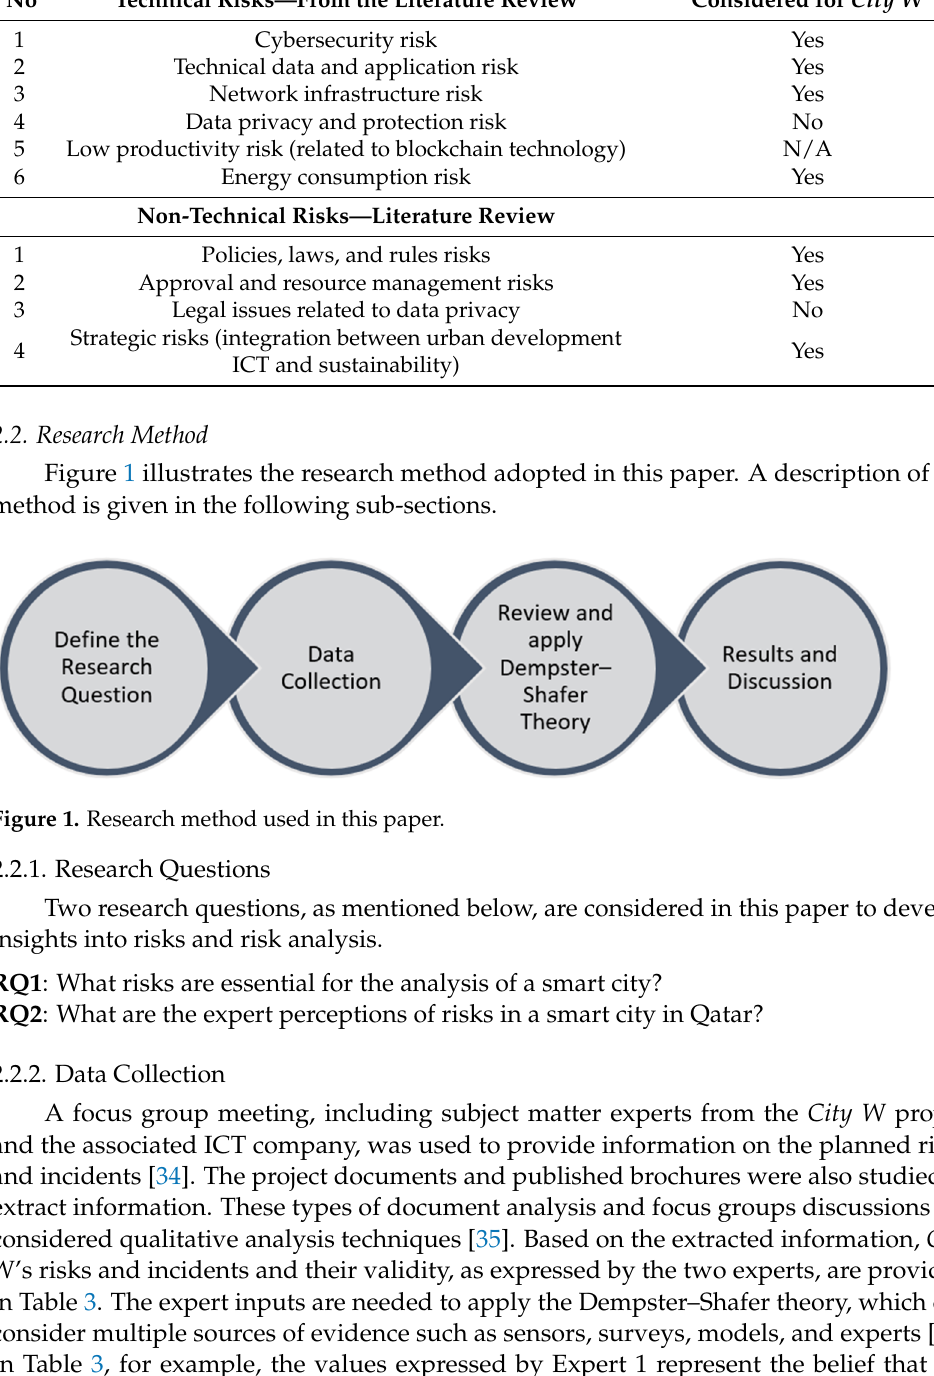
Table 3. The incidents causing risks and experts’ results.